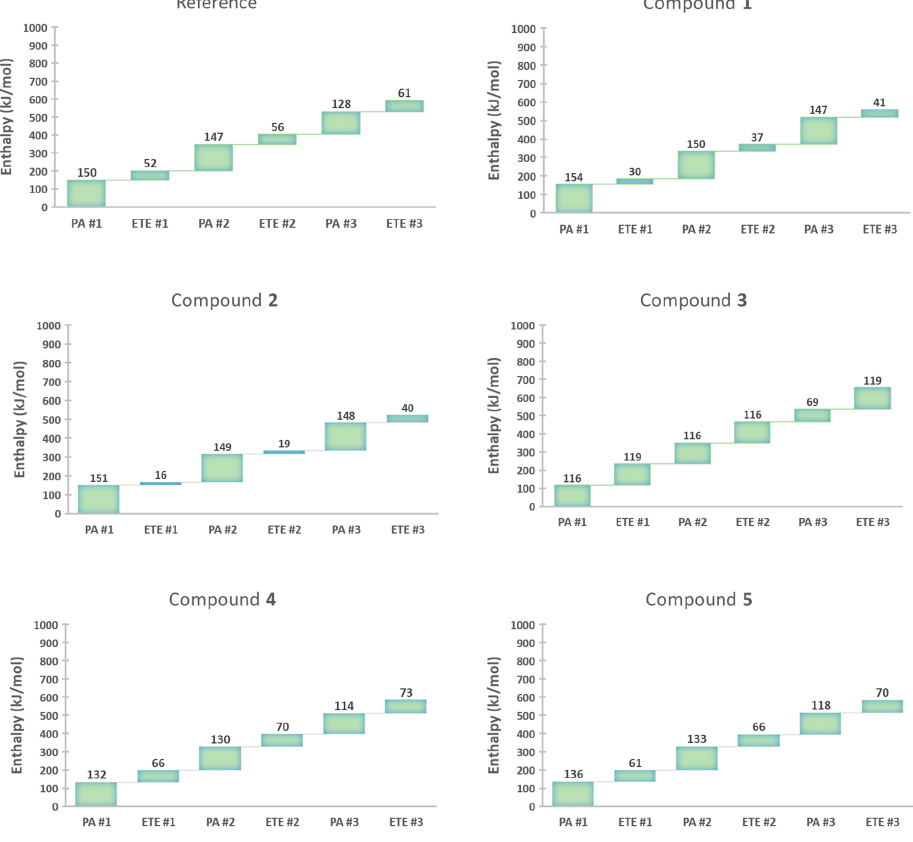
Figure 4. Enthalpy value of each step in a multiple SPLET process for the compounds studied. Each ETE value has